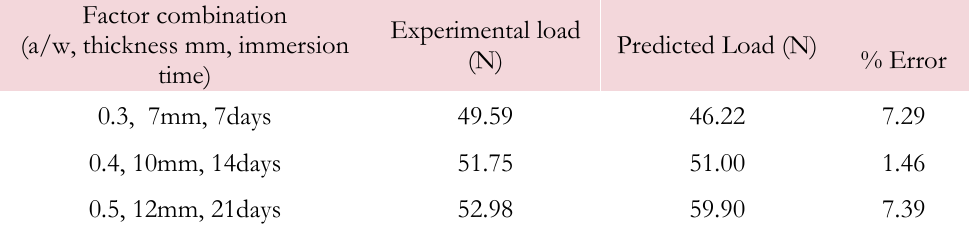
Table 8: Confirmation Test table for Fracture toughness MPa m½.